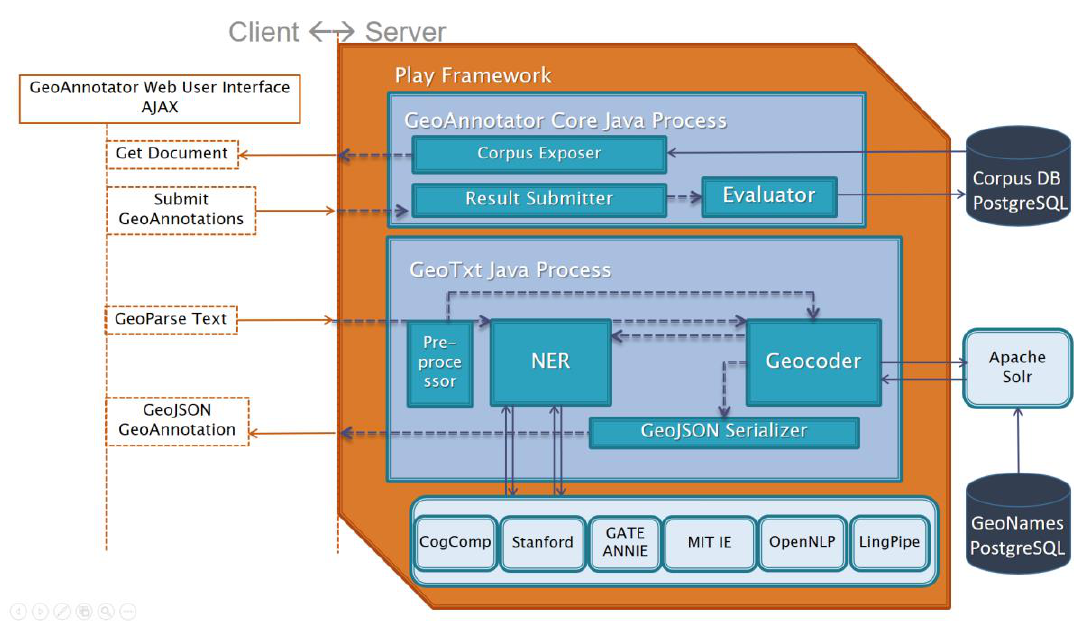
Figure 15. General architecture of GeoAnnotator. The Play framework is used to expose Java application programming interfaces (APIs) as HTTP web-service endpoints.